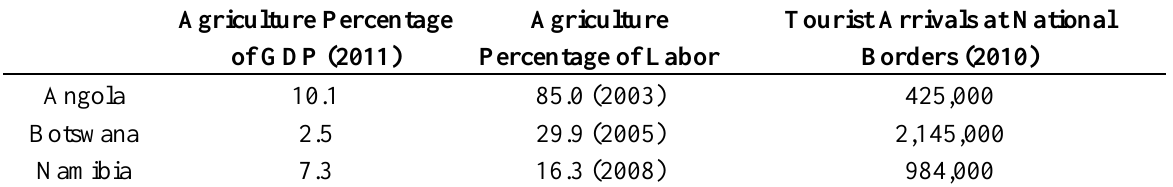
Table 3. Agriculture and tourism in Angola, Botswana and Namibia